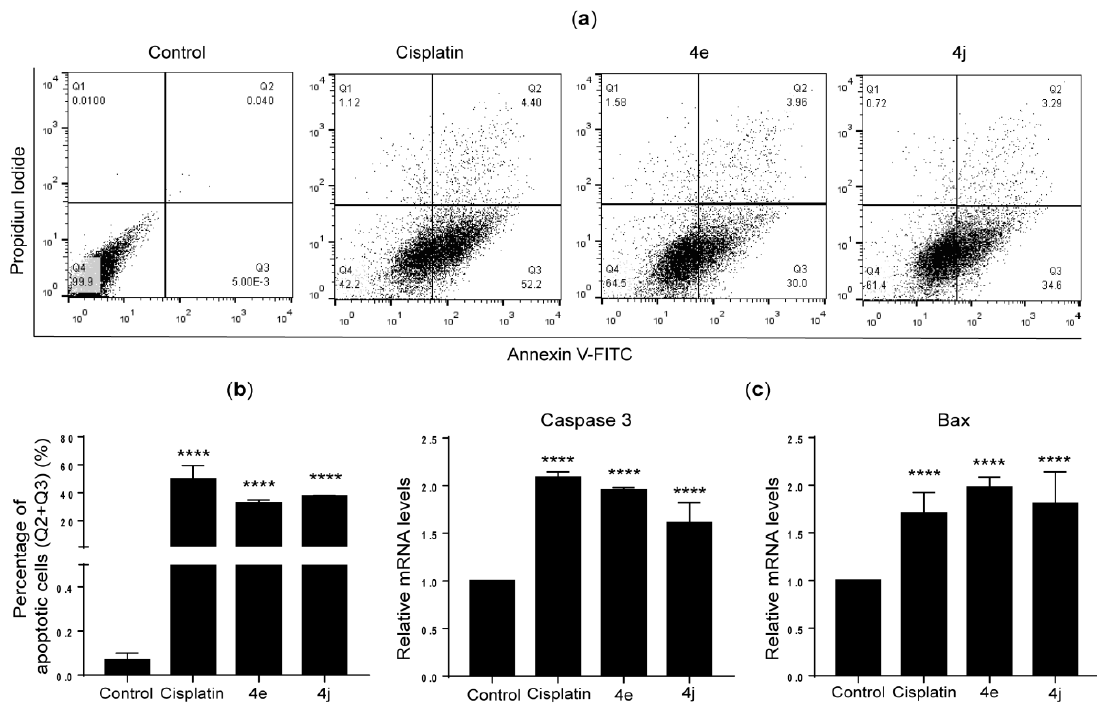
Figure 4. Selected DHT derivatives induce apoptosis in PC-3 prostate cancer cells. ( a ) Dot plots of annexin V / PI-based apoptosis detection and ( b ) quantification of apoptotic cells. ( c ) Bar graph of relative mRNA levels of caspase 3 and Bax in PC-3 cells. Data are presented as the mean ± standard deviation (SD). **** p < 0.0001 (Fisher’s LSD test).